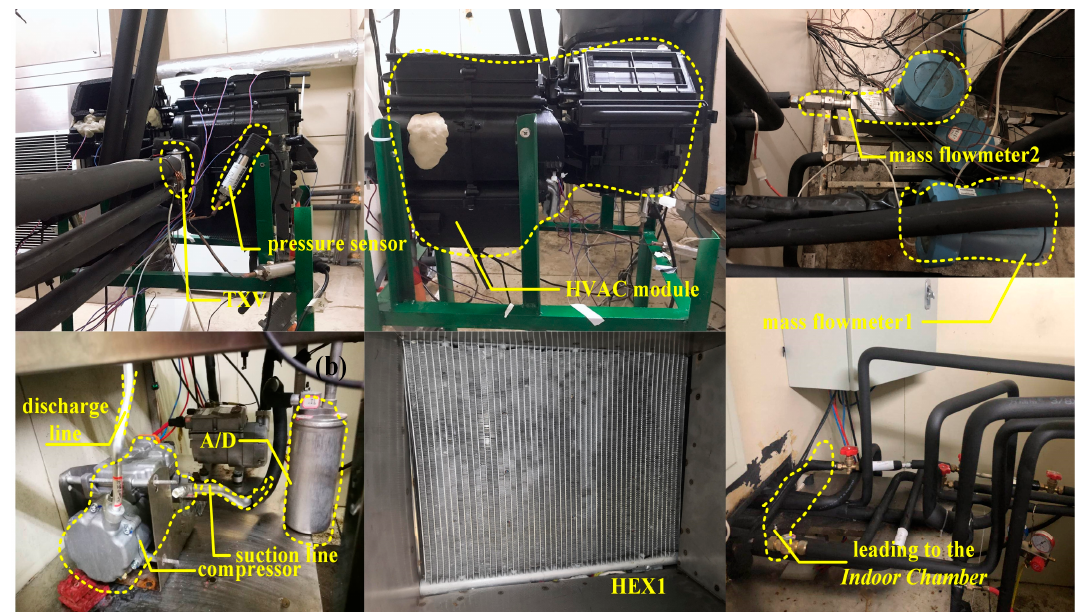
Figure 4. Experimental system and components.